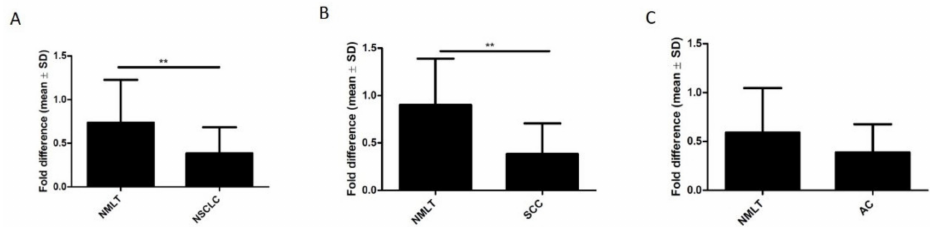
Figure 6. Expression of zyxin in NSCLC ( A ), in the SCC subtype ( B ), and in the AC subtype ( C ) compared with control tissue; Western Blot. Paired t-test (** p < 0.01).